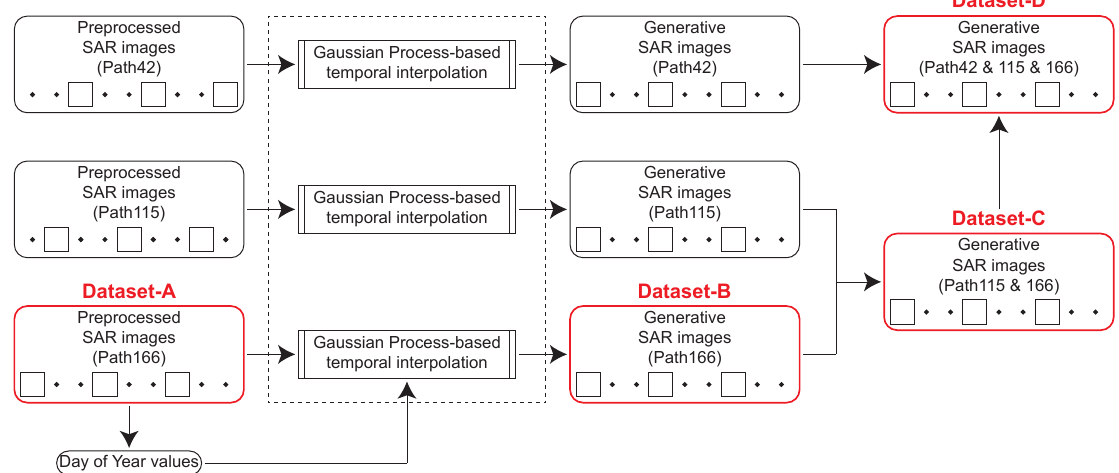
Figure 12. Workflow for creating